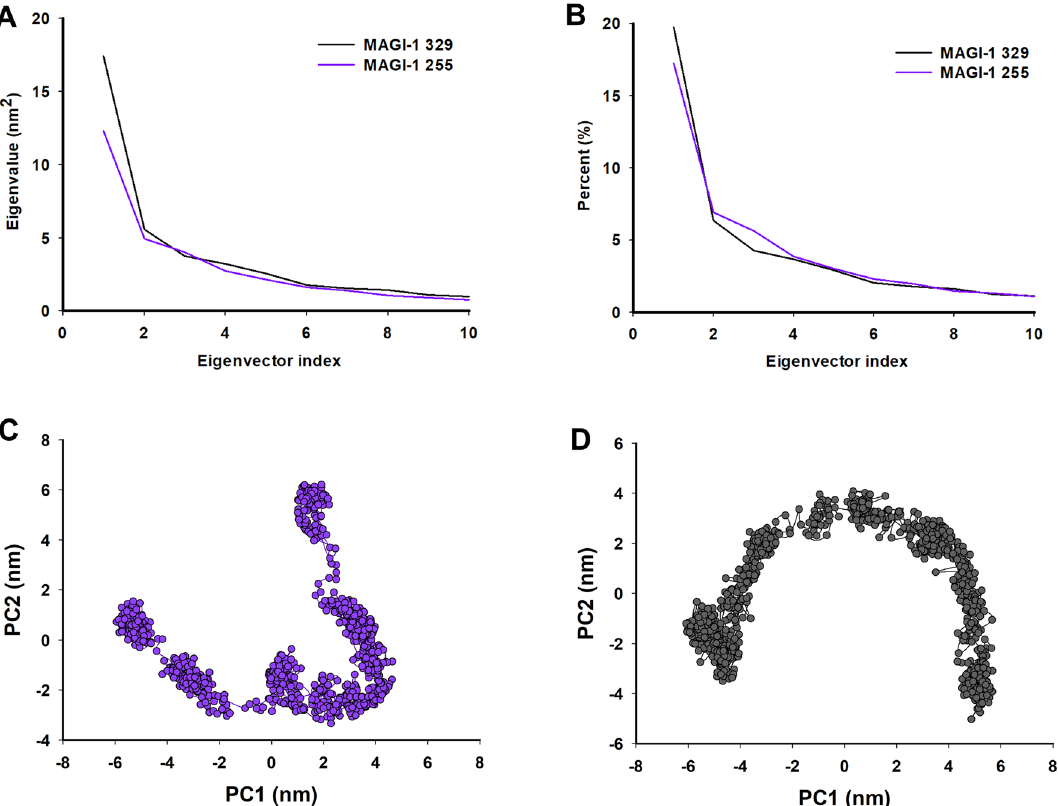
Figure 6. Principal component analysis (PCA) of MAGI-1 255 and MAGI-1 329. ( A ) First ten eigenvalues plotted against the corresponding eigenvector indices obtained from the Cα covariance matrix constructed from the 200 ns MD trajectory. MAGI-1 255 purple and MAGI-1 329 black. ( B ) Percentage of each eigenvector vs. eigenvalues. 2D Projection of Principal Component Analysis. Projection of the motion of the protein in phase space along the first two principal components. ( C ) MAGI-1 255 and ( D ) MAGI-1